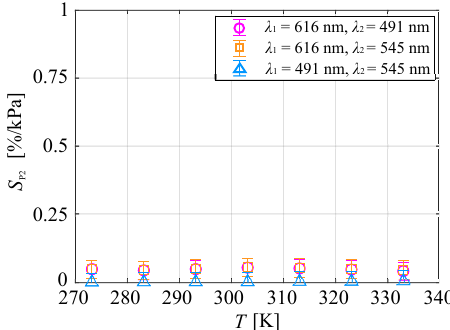
Figure 17. Pressure sensitivity as a function of the